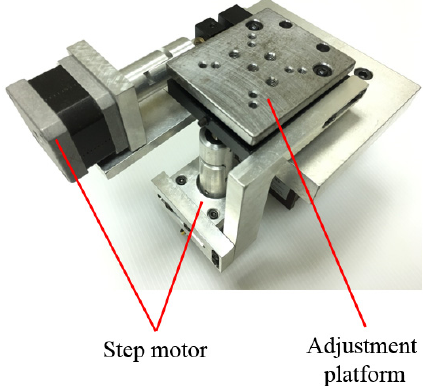
Figure 5. Fine alignment.